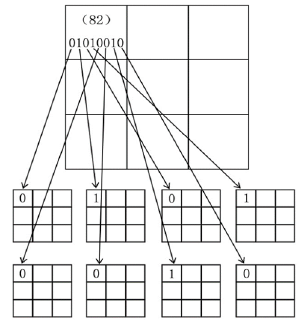
Figure 5. Schematic diagram of gray generation algorithm.